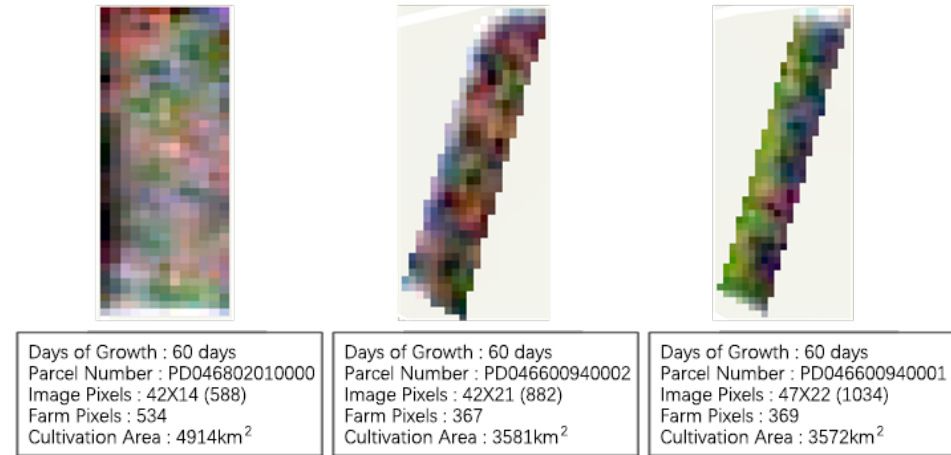
Figure 14. Satellite images of cabbages (60 days).